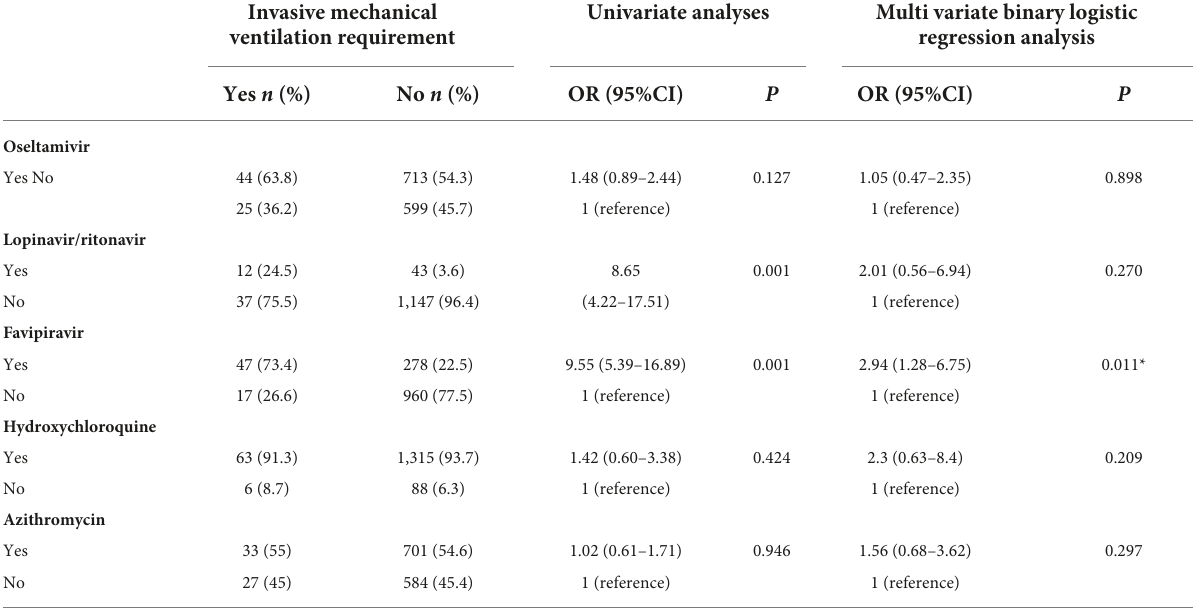
TABLE 4 The association between the use of treatment drugs and the requirement for invasive mechanical ventilation. Invasive mechanical Univariate analyses Multi variate binary logistic ventilation requirement regression